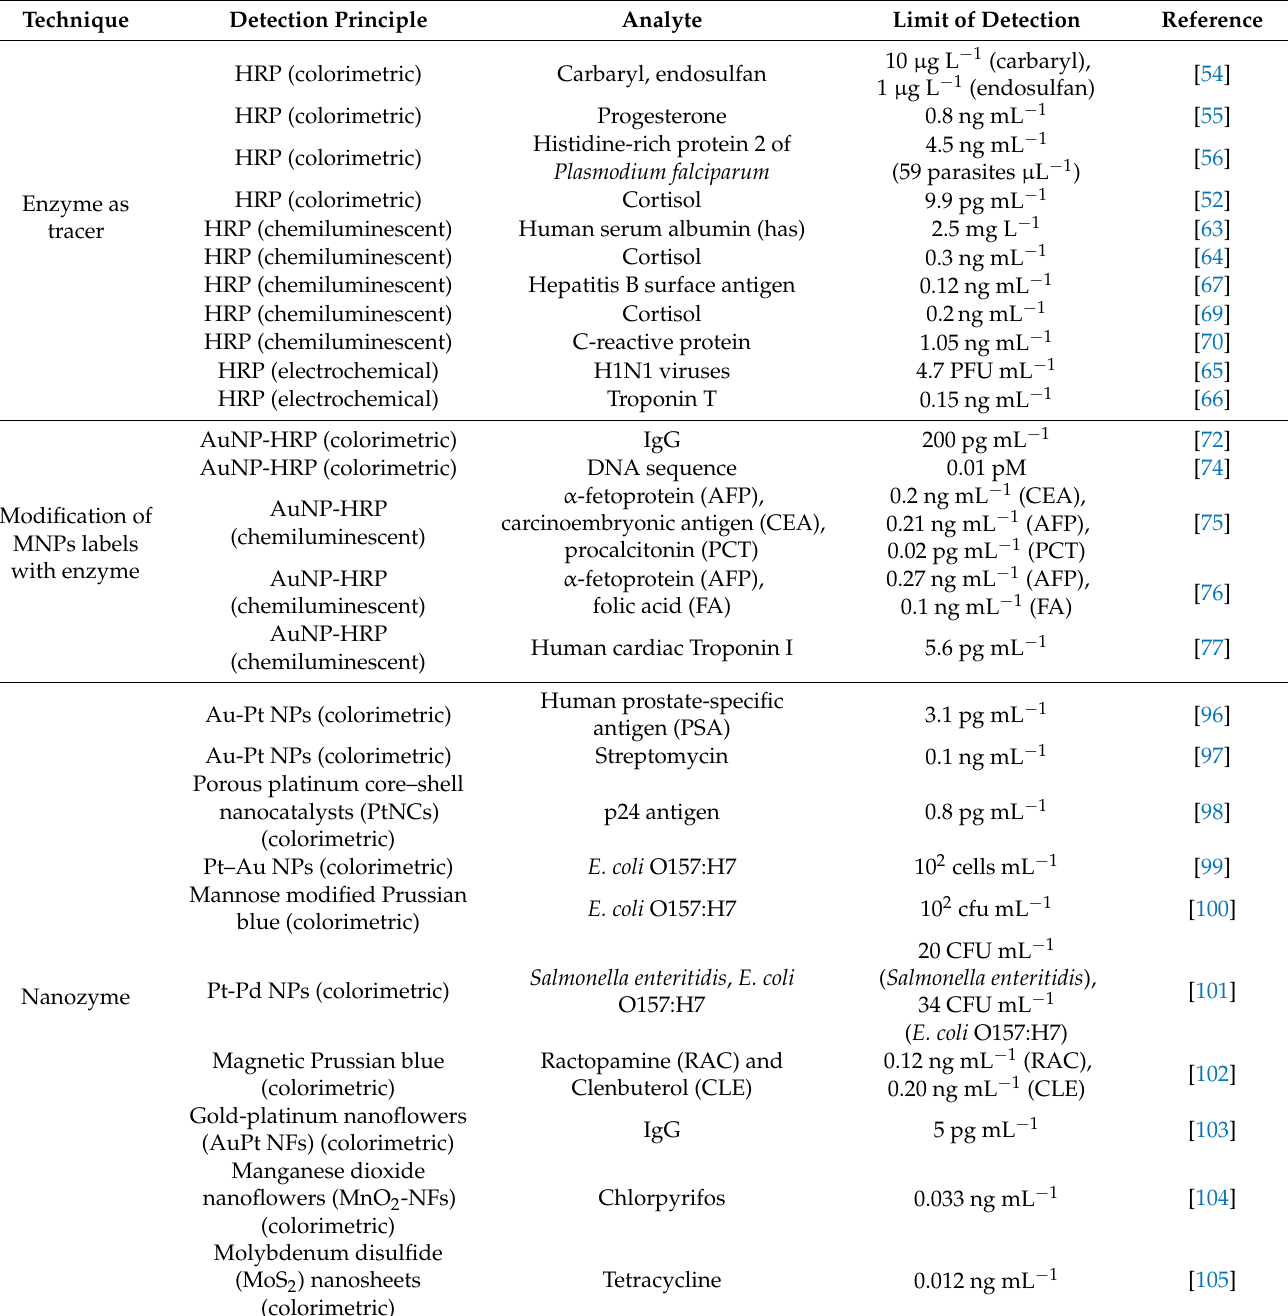
Table 2. Scheme of the work reported in literature exploiting enzyme-based